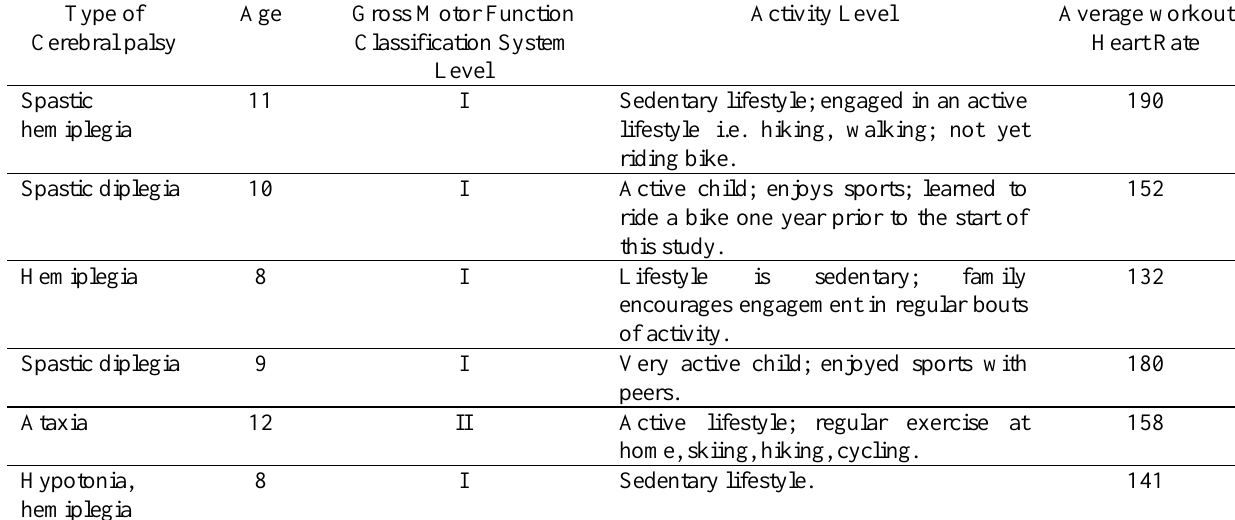
Description of the Study Participants Type